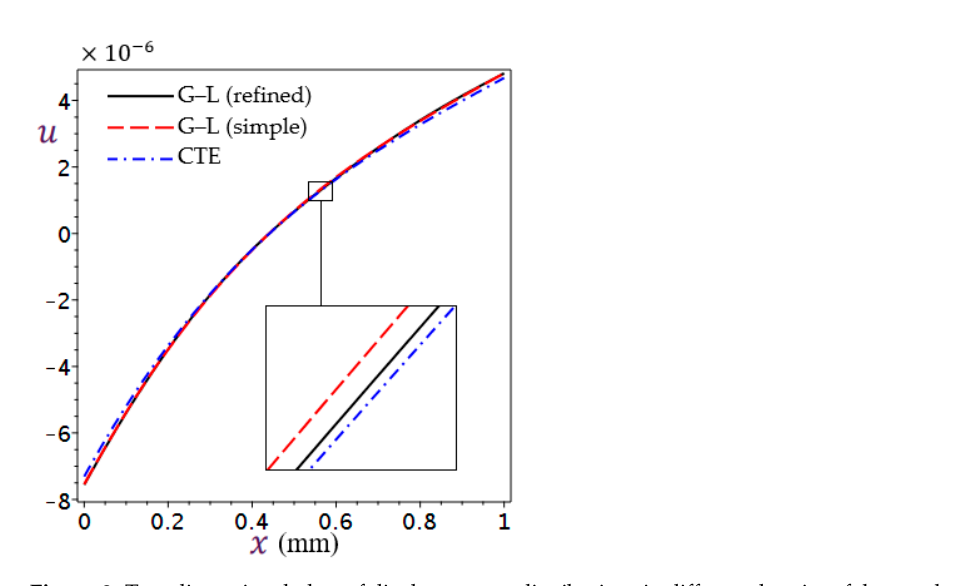
Figure 3. Two-dimensional plots of displacement 𝑢 distributions in different theories of thermoelasticity.